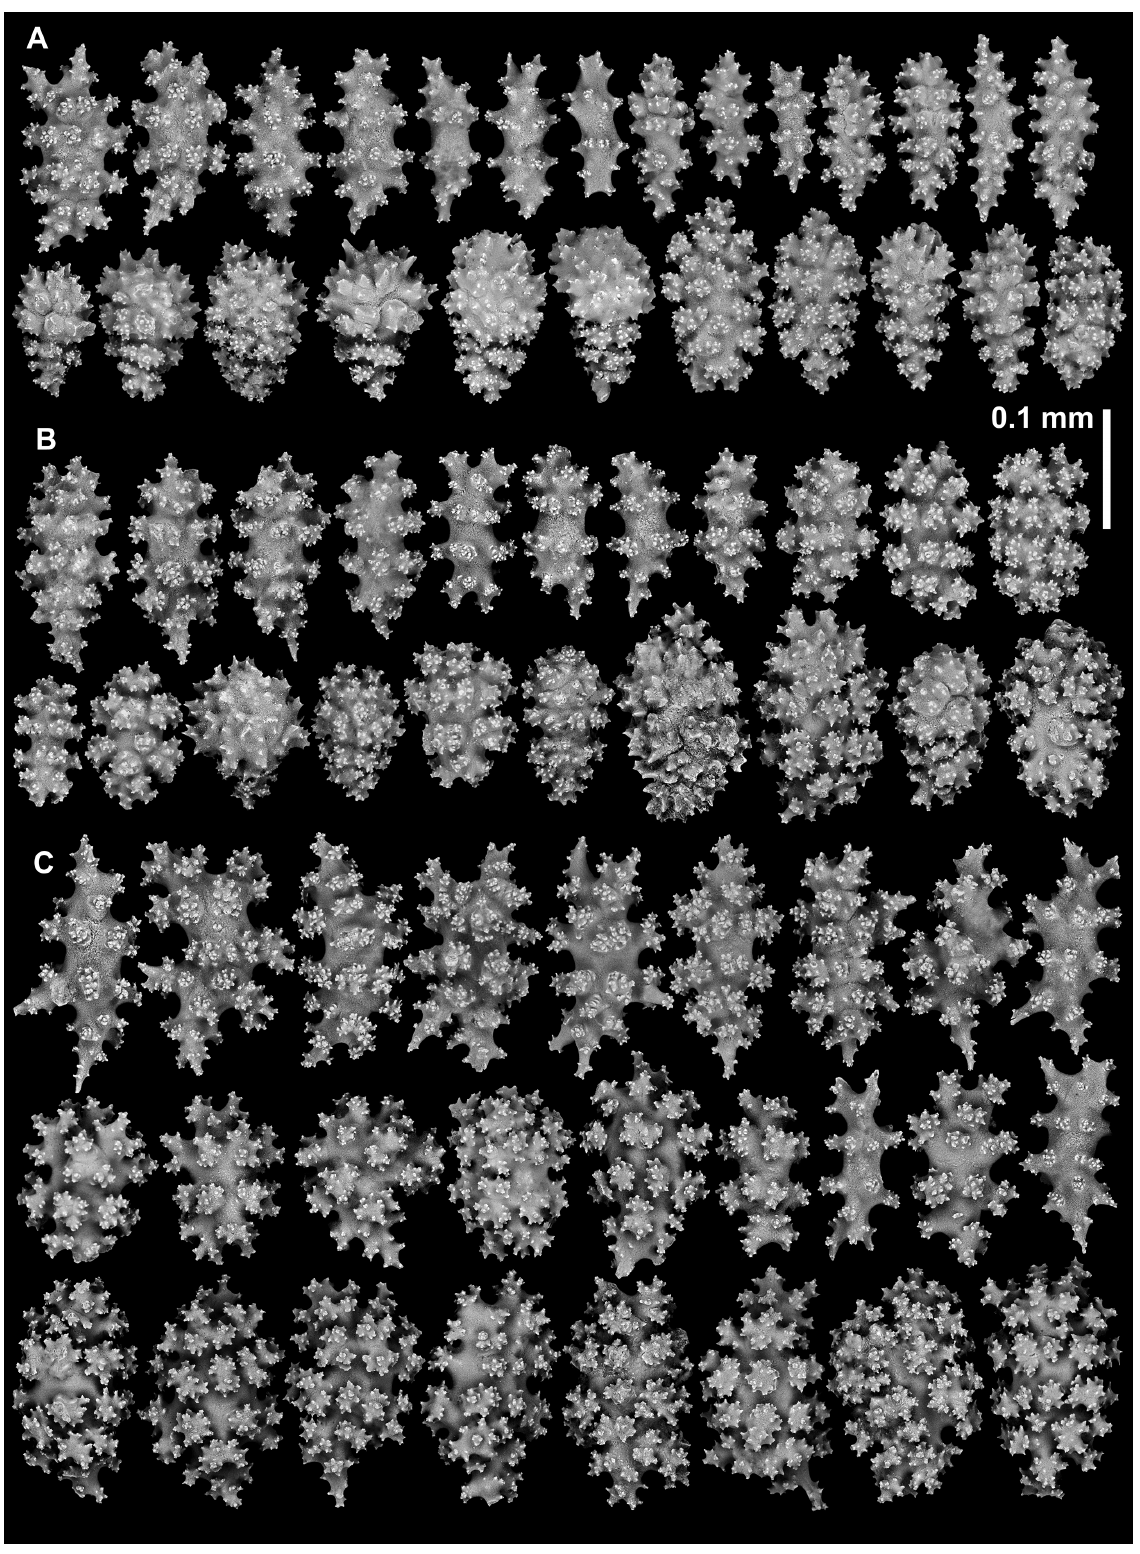
Fig. 16. Kotatea kurakootingotingo gen. et sp. nov., holotype (NIWA 101538), SEMs of sclerites. A . Polyp mound. B . Lobe surface. C . Lobe